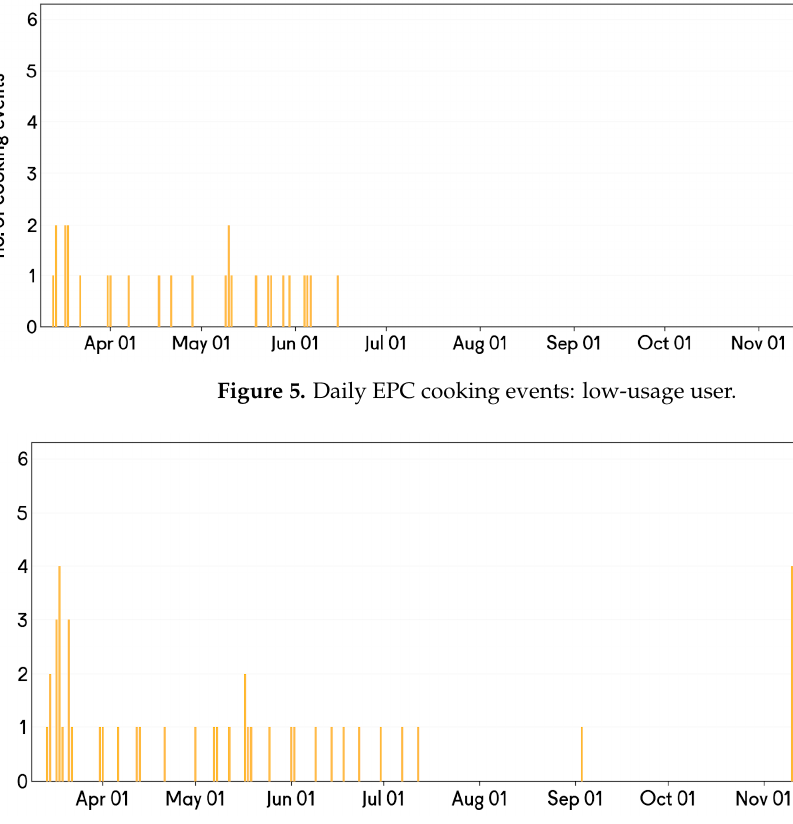
Figure 6. Daily EPC cooking events: medium-usage user.